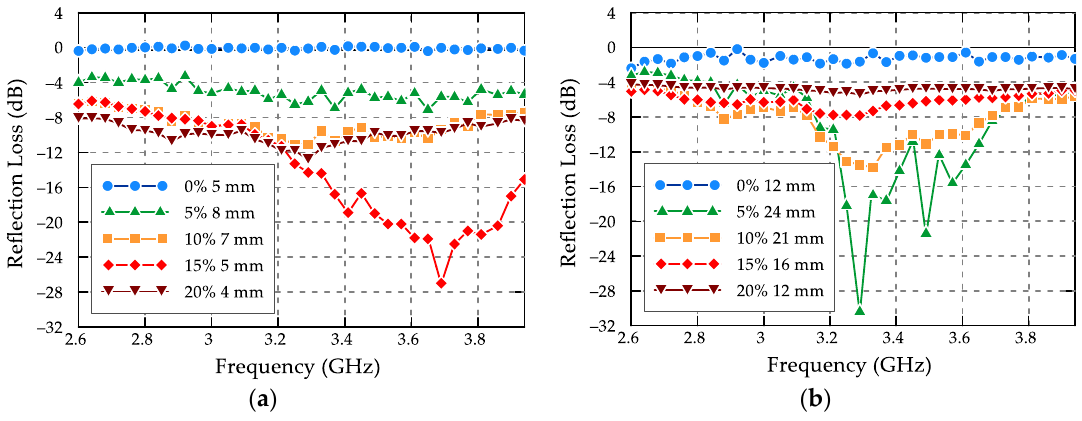
Figure 4. Reflection loss versus frequency at different weight contents of magnetite in cement-based composite (the data extracted from the plots presented in [64]): ( a ) at thin matching thickness and ( b ) at thick matching thickness.